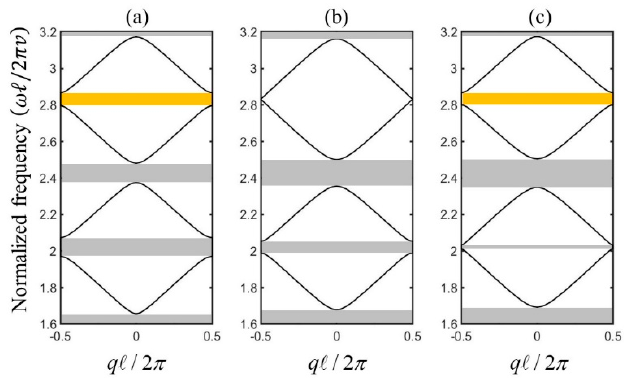
Figure 3. ( a – c ) are the band structures (solid black curves) of ES-I, a band-crossing ES system, and ES-II, respectively. The material parameters are listed as follows: ρ A = 2704 kg / m 3 , ρ B = 8100 kg / m 3 , (cid:96) = 0.6759 (cid:96) and (cid:96) = 0.3241 (cid:96) ; ρ = 2704 kg / m 3 , ρ = 8836 kg / m 3 , (cid:96) = A B 1 ,band crossing 2 ,band crossing 1 ,band crossing 0.7068 (cid:96) and (cid:96) 2,band crossing = 0.2932 (cid:96) ; ρ C = 2704 kg / m 3 , ρ D = 9580 kg / m 3 , (cid:96) C = 0.7316 (cid:96) and (cid:96) D = 0.2684 (cid:96) . The gap where the band inversion occurs is highlighted in